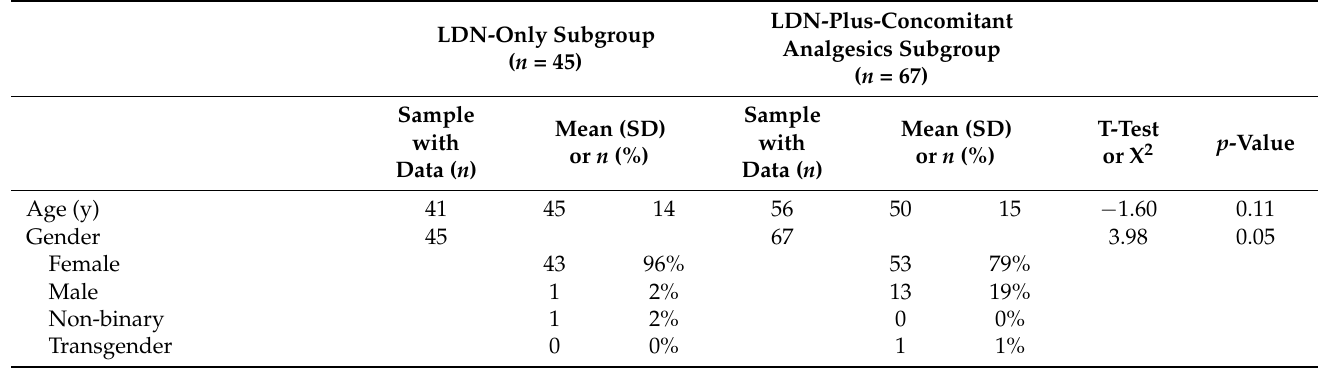
Table 5. LDN-Only vs. LDN-plus-Concomitant Analgesic Subgroup